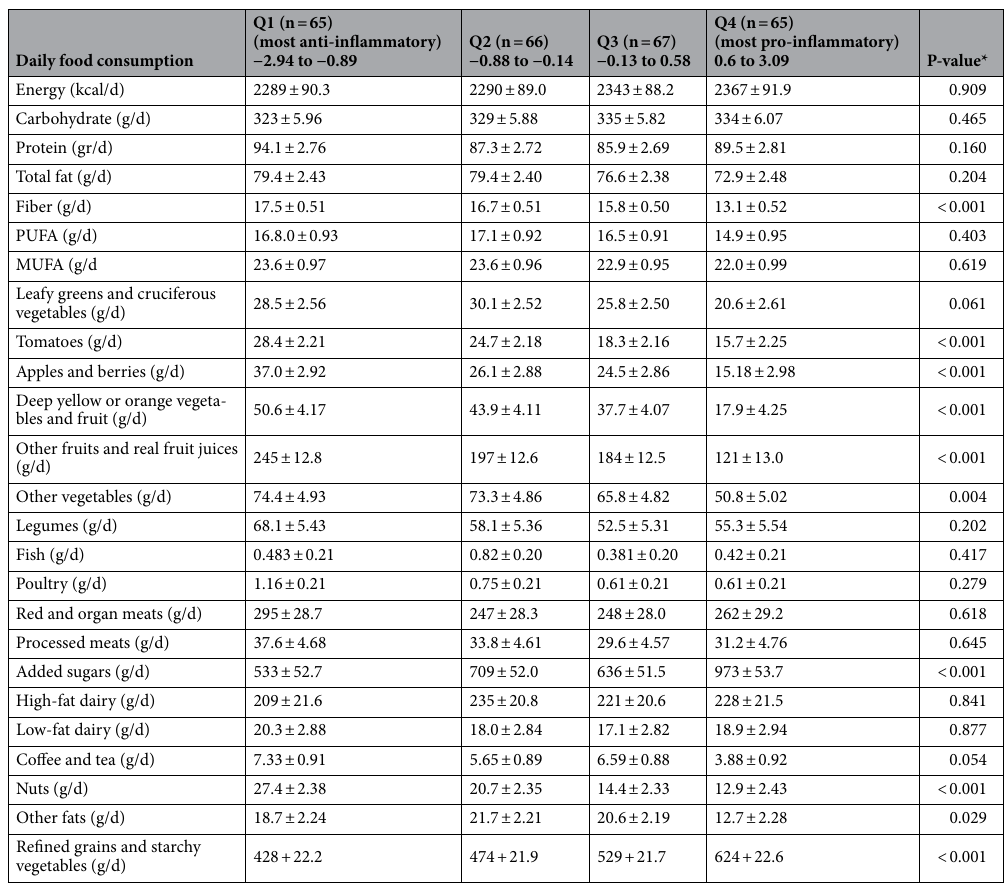
Table 2. Daily food consumption according to quartile of the dietary and lifestyle inflammation score for the participants. Q, quartile. Data are expressed as mean ± SE. * Obtained from ANCOVA test. Energy intake is adjusted for age and sex, all other values are adjusted for age, sex, and energy